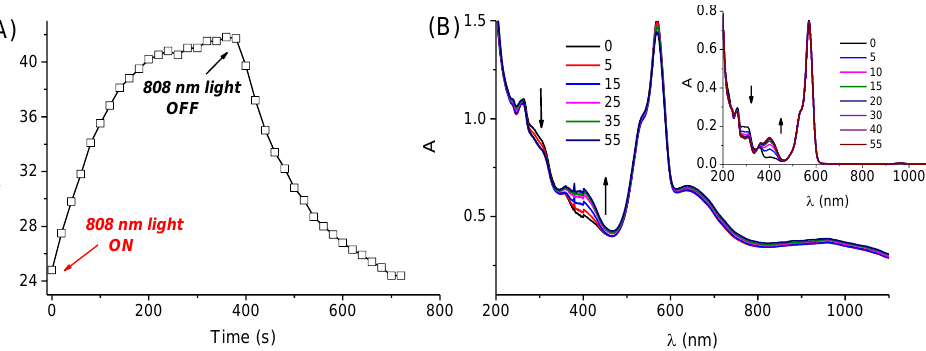
Figure 6. ( A ) Temperature changes observed upon 808 nm CW laser irradiation (6 W cm −2 ) for the aqueous dispersion of the Au@PolyCD@RD-NO complex. ( B ) Absorption spectral changes observed from 0 to 55 min of 532 nm CW laser irradiation (6 W cm −2 ) light irradiation of the aqueous dispersion of Au@PolyCD@RD-NO. The arrows indicate the course of the spectral profile with the illumination time. The inset shows the same spectral changes observed for the RD-NO (7 µM) encapsulated within PolyCD (2 mg mL −1 ) in the absence of Au.